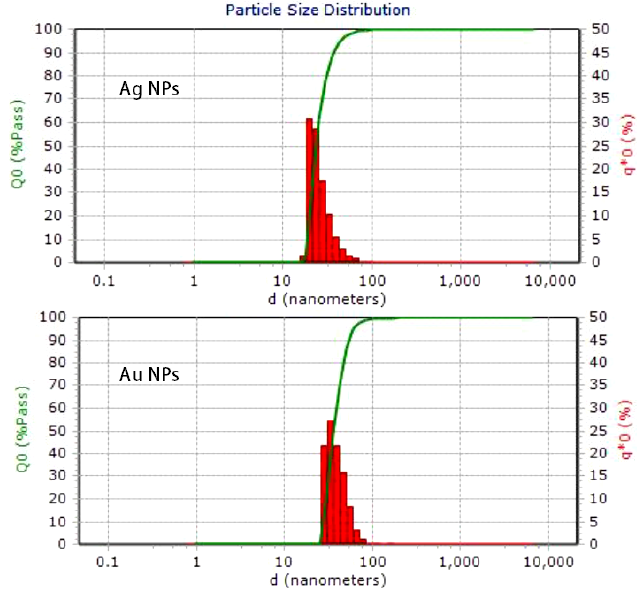
Figure 3. Particle size distribution of silver and gold nanoparticles .